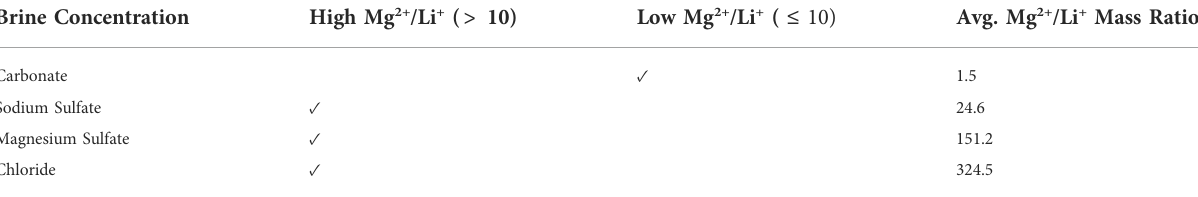
TABLE 2 Classi fi cation of the four major brine types according to Mg 2+ /Li + mass ratio. Brine